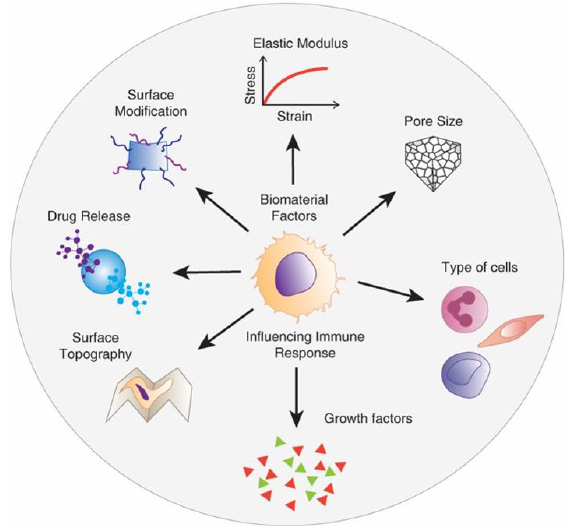
Figure 10. Schematic showing material design factors influencing the macrophage-mediated foreign body response to biomaterial implants including pelvic floor reconstruction. Reproduced with permission of [101].